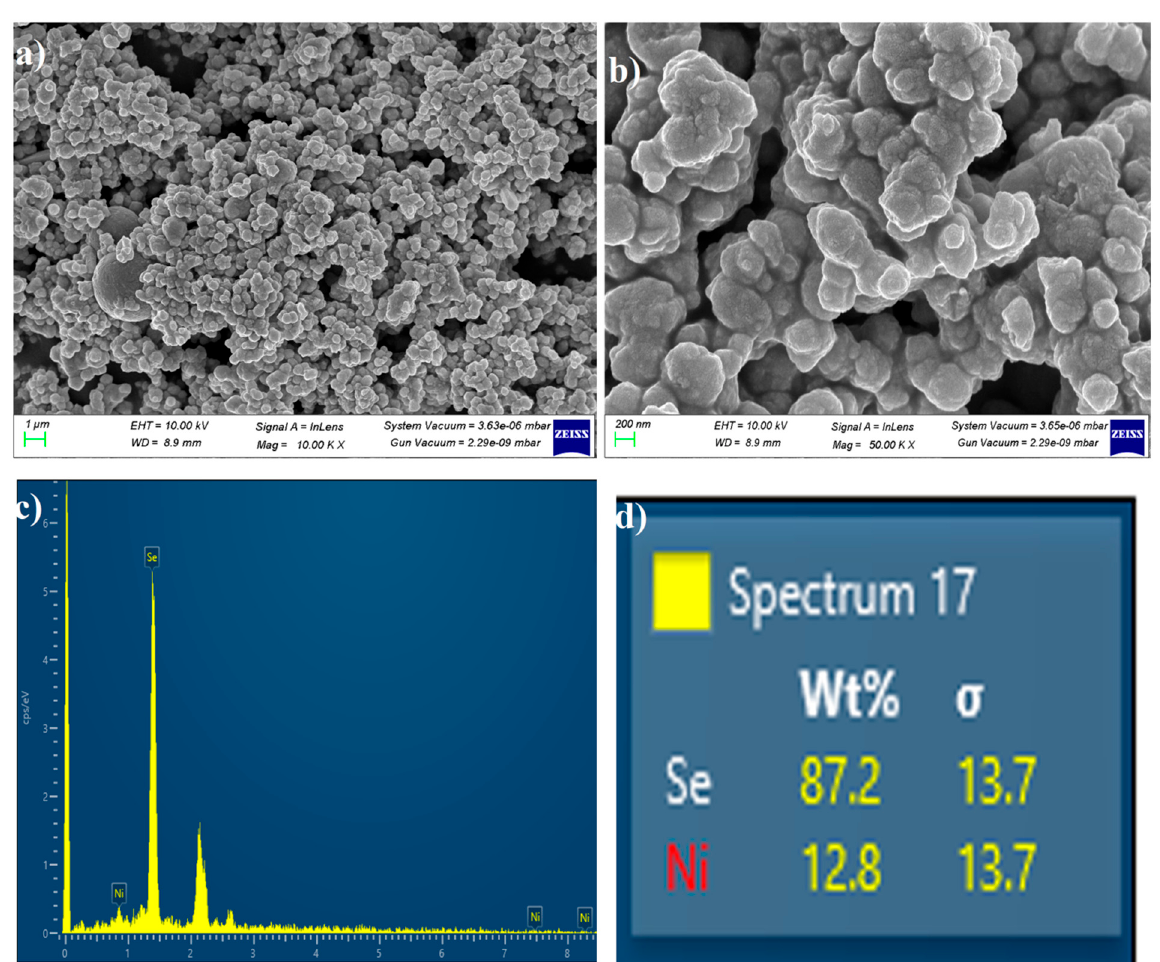
Figure 4. ( a , b ) SEM and ( c , d ) EDAX analysis of green synthesized NiSe NPs.